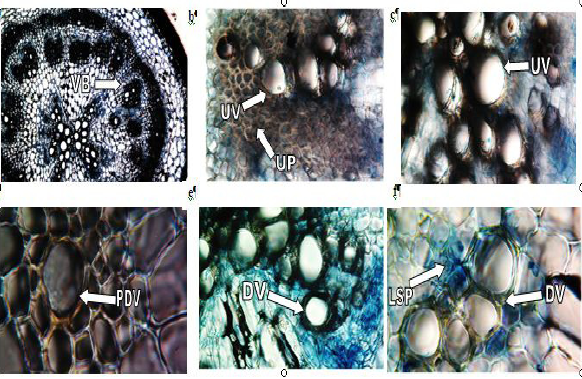
Fig. 4. Transverse section of the root of A. hybridus of the Control (a) showing vascular bundles (VB) with no pathologi- cal condition, (b) Control with undamaged vessels (UV) and phloem (intact structural integrity) (UP), (C) 10% treatment with undamaged and numerous vessels(intact structural integri-